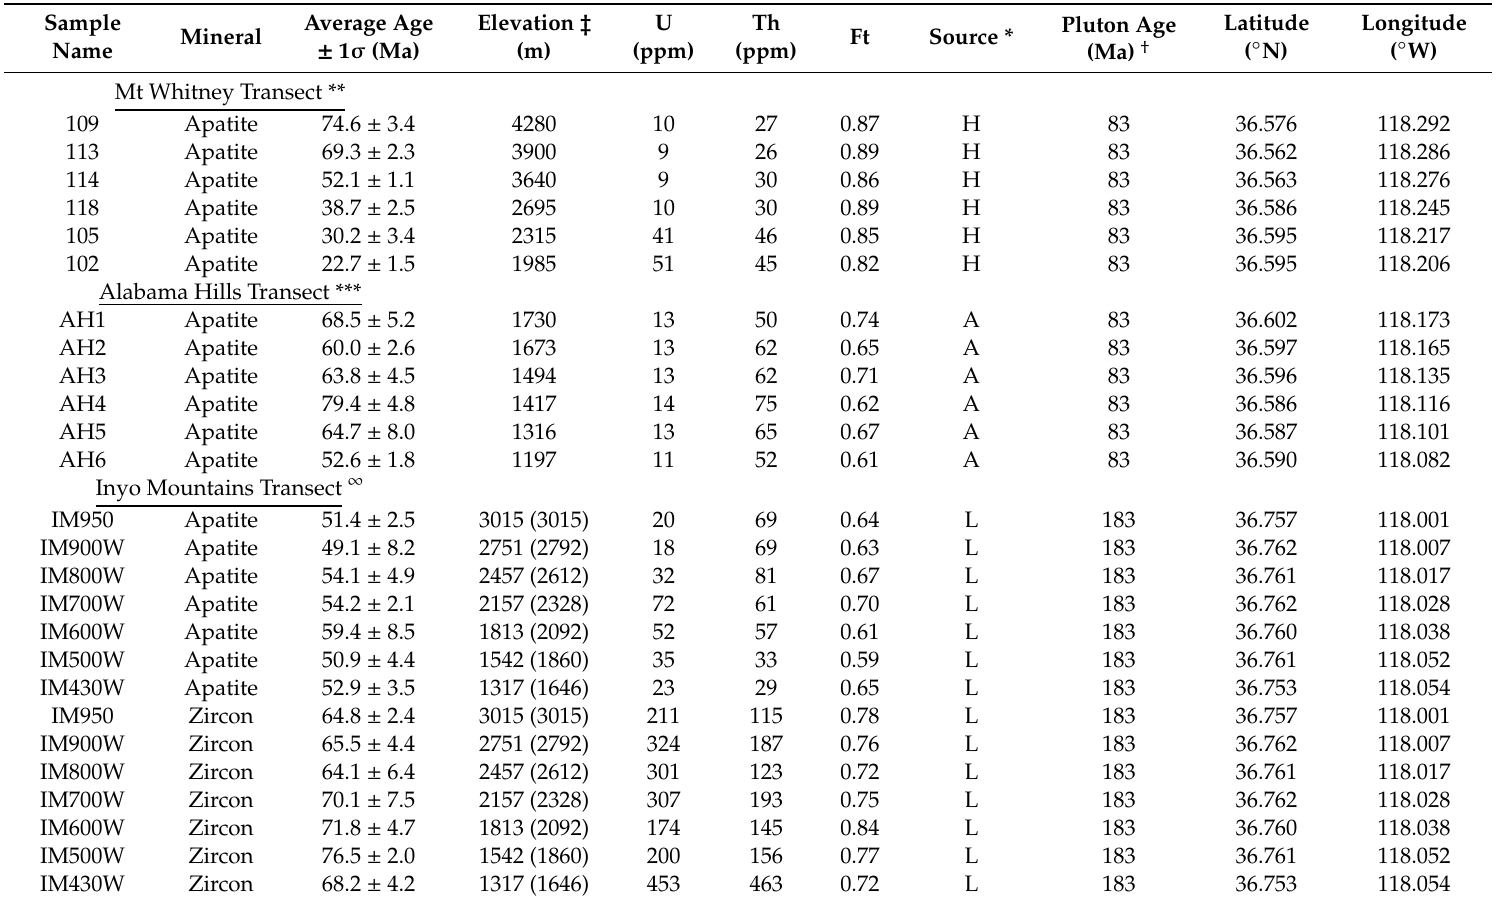
Table 1. Apatite (U-Th) / He